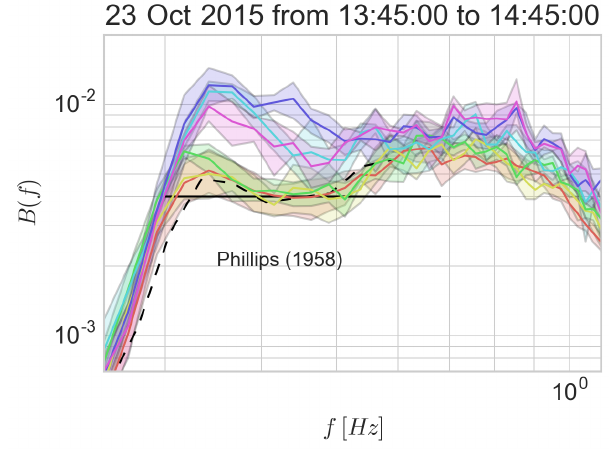
Figure 8. Variance spectral density evolution over time; 10min Fourier transform from 23 October 2015 13:40 to 14:40UTC. The gray dashed lines shows the wind-sea saturation f − 4 and noise floor at E(f )f 4 limits for the first 10min of acquisition. The color of the lines follows the buoys’ displacement as in Fig. 6. The solid lines shows the spatial mean of the spectral density measured in f r during each 10min acquisition. The lines’ shadow represent the 99% confidence interval. The dashed dark line is the spectral den- sity measured by Pierre Noires Datawell Waverider buoy at a nearby offshore location, outside the current region.